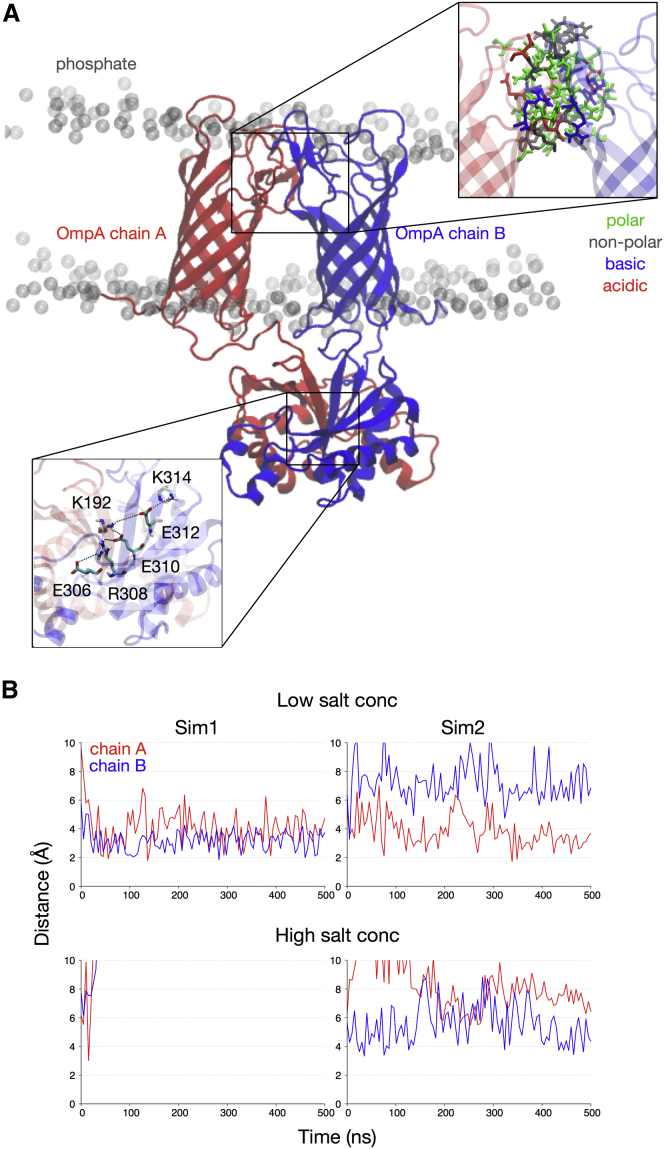
OmpA dimerization interface. (A) The N-terminal β-barrels dimerize via nonspecific polar and nonpolar interactions between residues found in the loop regions (top inset), whereas the C-terminal periplasmic domains interact via a network of salt bridges (bottom inset). (B) Distance between the side chains of two residues, K192 and E310, which are key to the formation of the dimerization interface in the CTDs. The colors represent the two monomers in (A). In one high-salt concentration simulation (bottom left), the distance between the residues was >10 Å after ∼40 ns of simulation. To see this figure in color, go online.